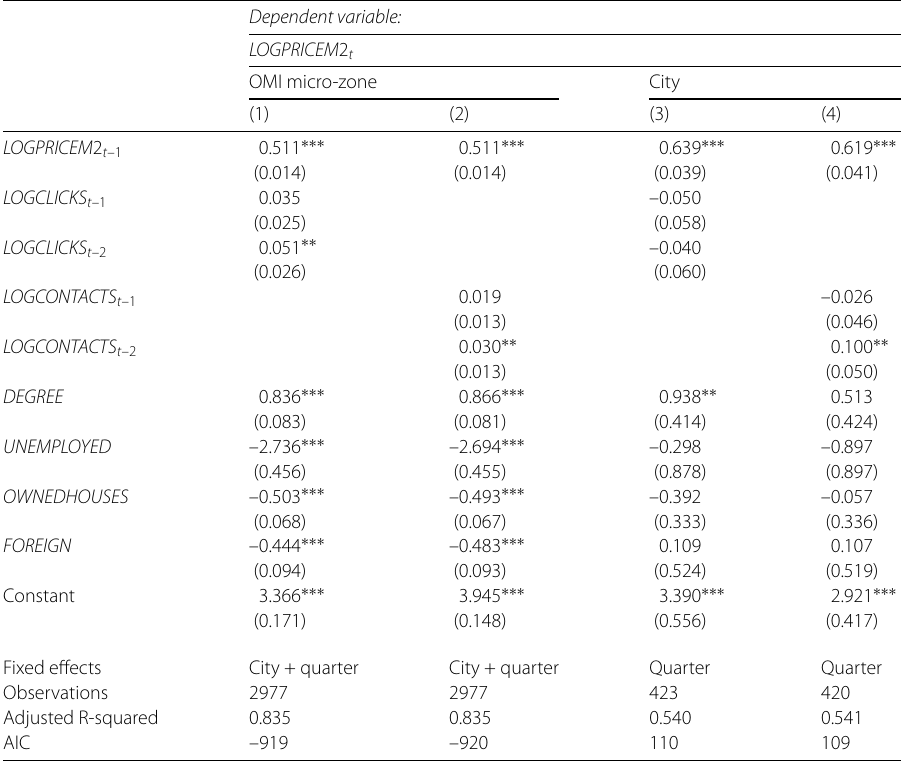
Table 4 Lagged effect of aggregate online interest on price Dependentvariable: LOGPRICEM 2 t OMI micro-zone